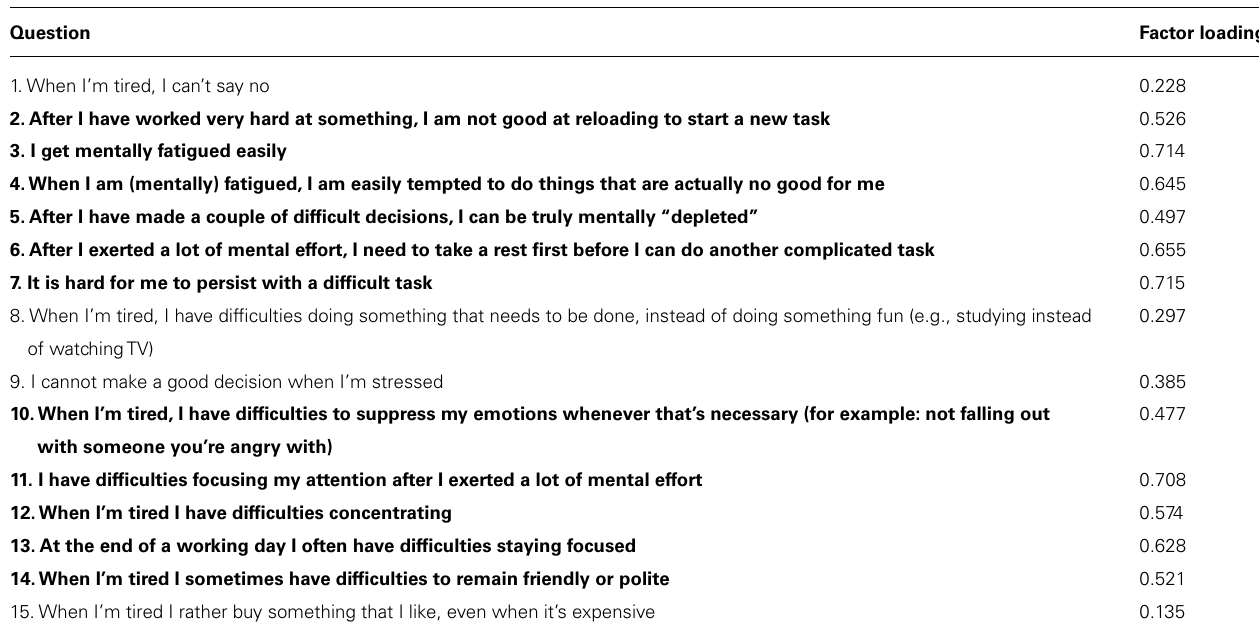
Table 1 | Factor loadings of 15 items on the depletion sensitivity factor, Study